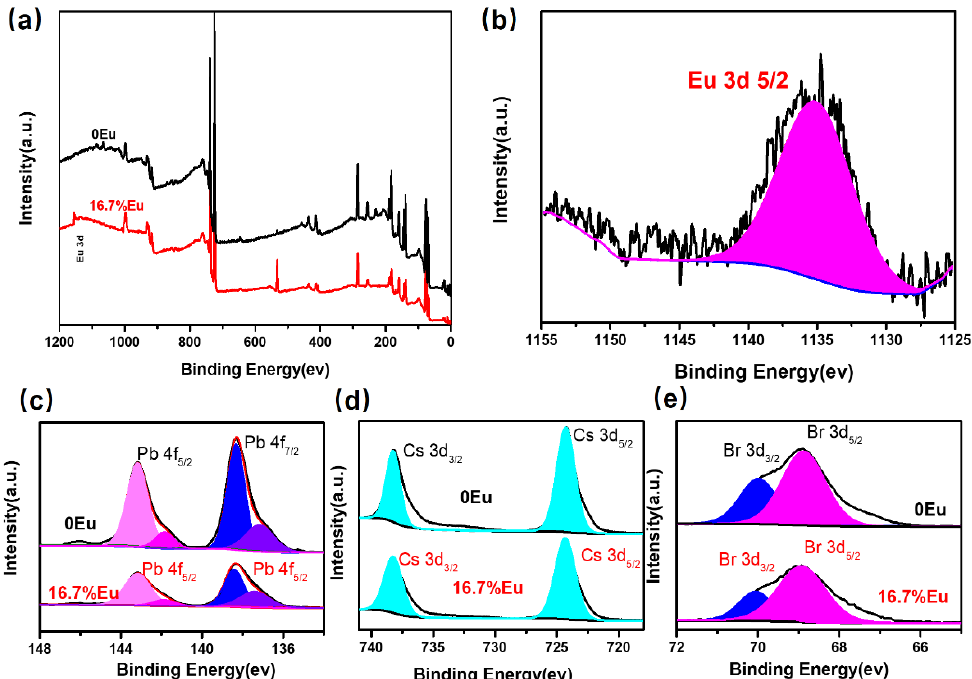
Figure 3. ( a ) XPS spectra of CsPbBr 3 /Cs 4 PbBr 6 and CsPbBr 3 /Cs 4 PbBr 6 :Eu 3+ (with an Eu 3+ doping concentration of 16.7%) and the binding energies of the corresponding orbitals: ( b ) Eu 3d, ( c ) Pb 4f, ( d ) Cs 3d, and ( e ) Br 3d.